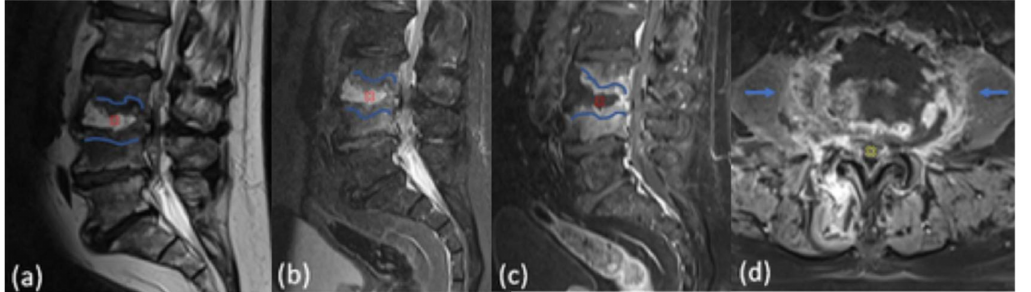
Figure 2. MRI TSE T2-weighted ( a ), STIR ( b ), and Dixon T1 CE+ ( c ) sequences on sagittal planes, and T1-weighted CE+ sequence on axial planes ( d ) show: subchondral bone erosions and bone edema at the end plates at the level L3–L4 (( a – c ), curvilinear blue lines); significant edema of the vertebral disc as “hot disc” (( a – c ), red point) with intense bone inhomogeneous enhancement of end plates; inhomogeneous enhancement in the adjacent soft tissues (( d ), blue arrow) and epidural abscess (( d ), yellow